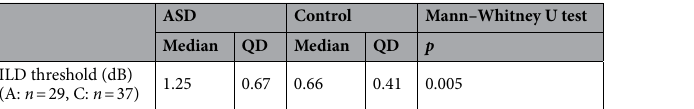
Table 3. Medians, quartile deviations, and p -values related to Mann–Whitney U test for the ILD thresholds.